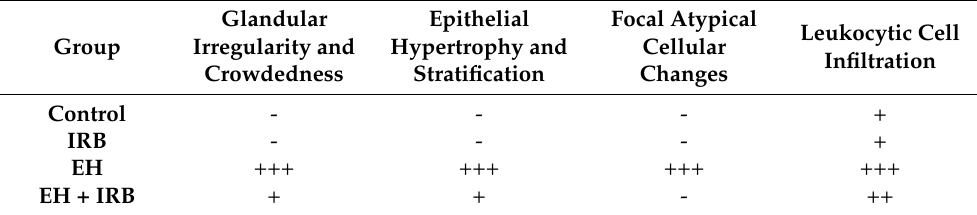
Table 2. Effect of irbesartan (IRB) on the severity of histopathological lesions in estradiol benzoate- induced endometrial hyperplasia (EH) and atypia in rats. Glandular Epithelial Focal Atypical Leukocytic Cell Group Irregularity and Hypertrophy and Cellular Infiltration Crowdedness Stratification Changes Control - - - + IRB - - -